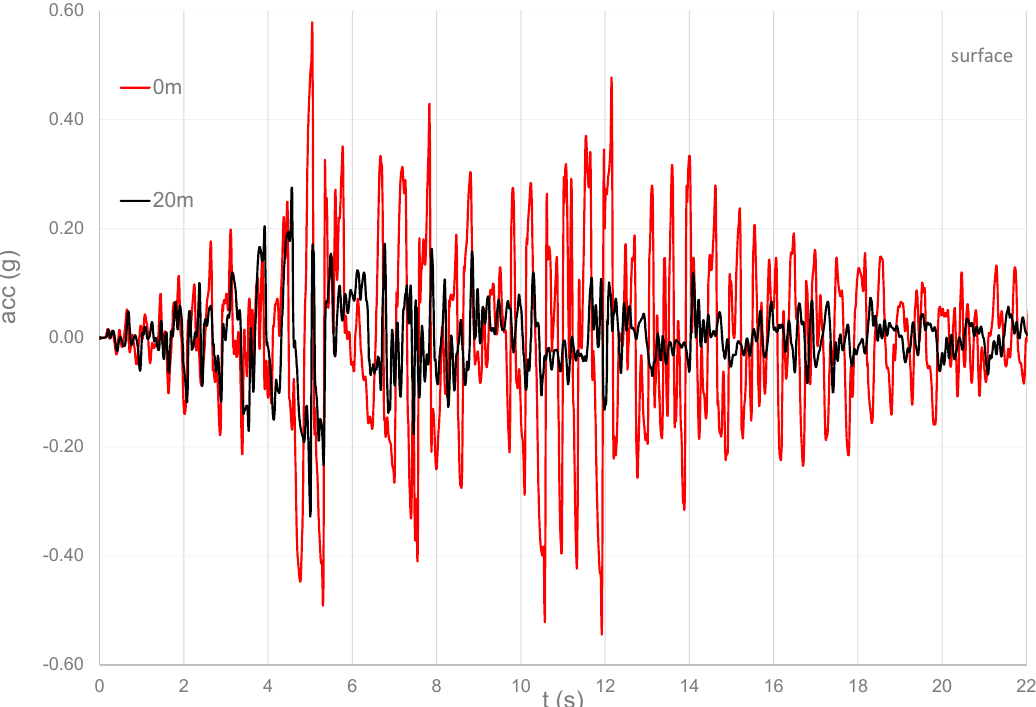
Figure 13. Acceleration time histories at the surface for model-0 m and model-20 m.